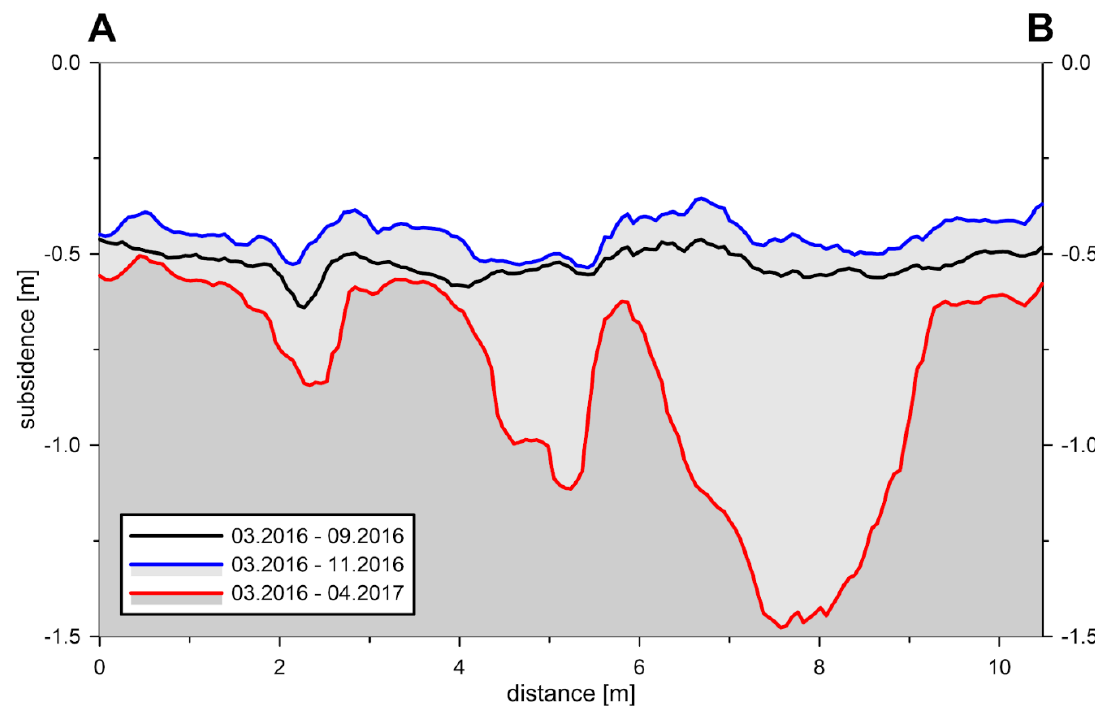
Figure 8. Subsidence profiles along an A–B discontinuous deformation based on results obtained using UAV photogrammetry (Piekary site).